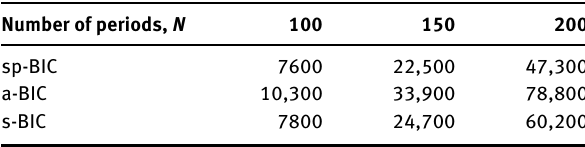
Table 1: Radiative Q factor ( Q ord ) for different types of BICs in structures of finite size consisting of N